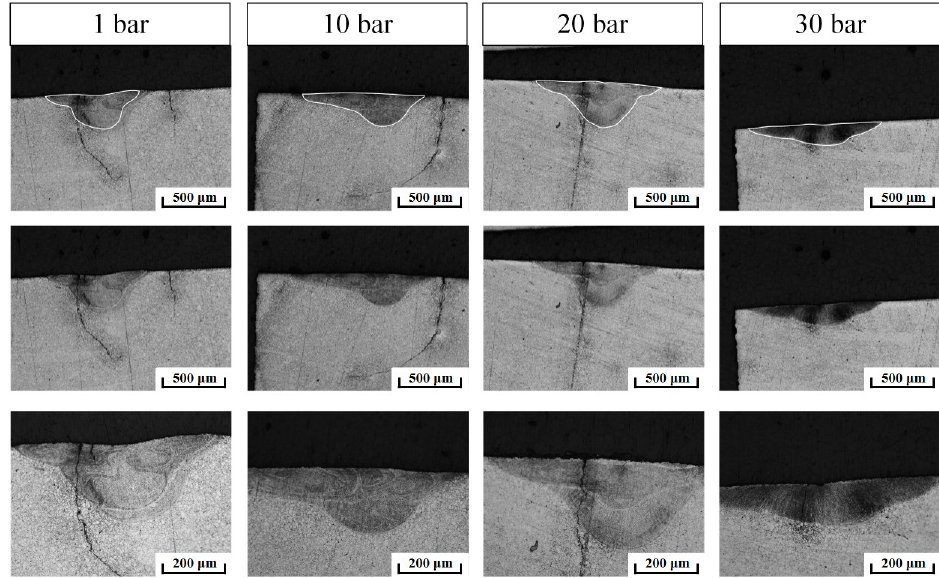
Figure 6. Cross-section shape of laser melting channel of beryllium under different ambient pres- sures.